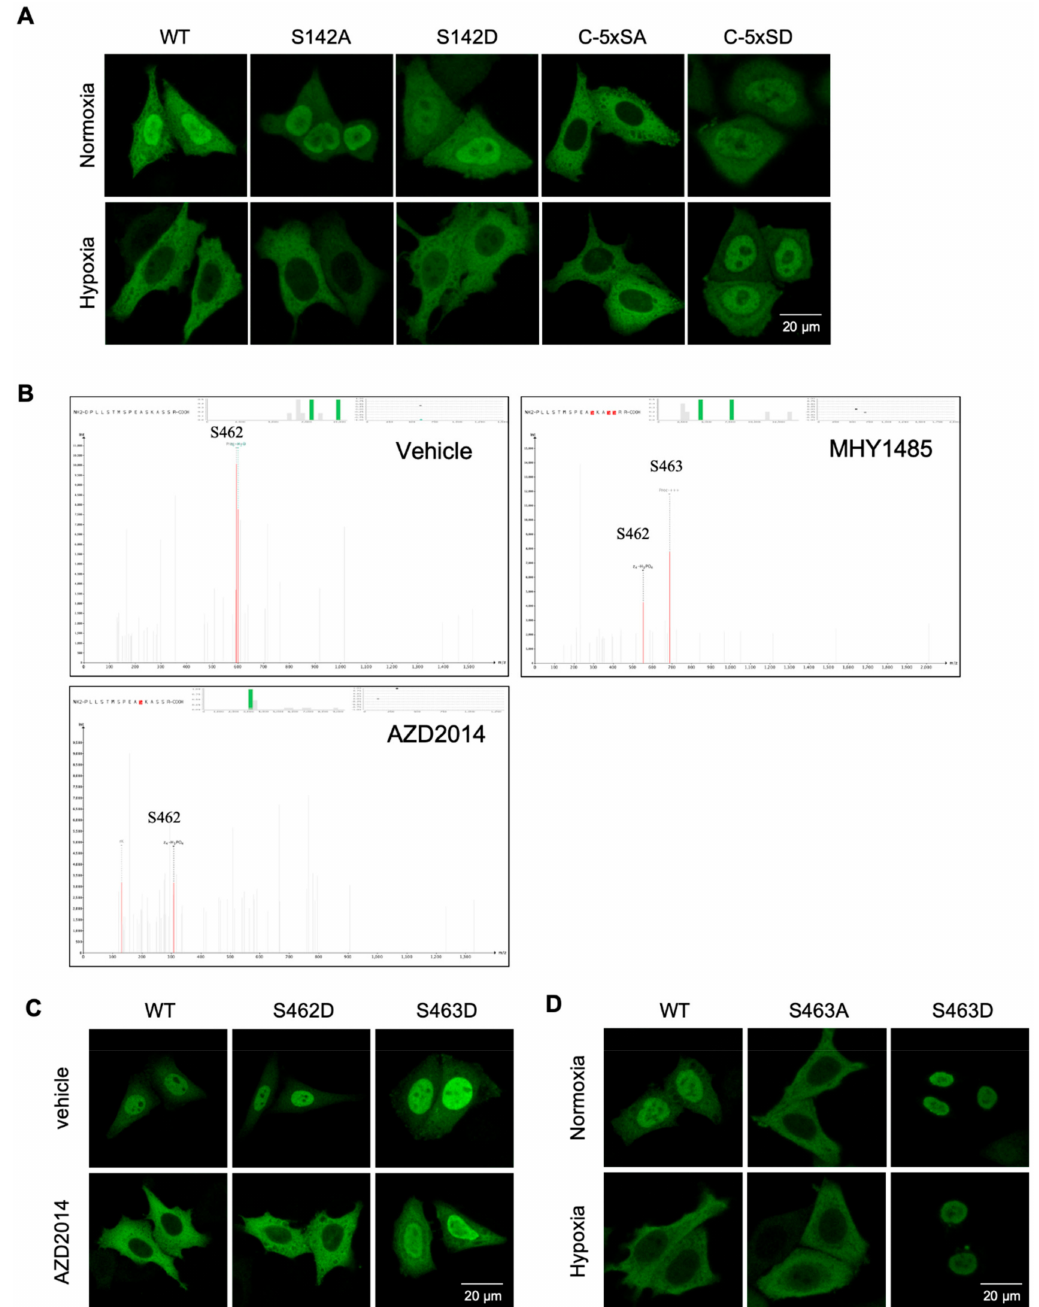
Figure 3. mTORc1 phosphorylates TFEB at S463. HeLa cells transfected with Myc tagged wild-type (WT) or TFEB mutant constructs were incubated in either 20% or 1% O 2 for 24 h, followed by immunostaining using Myc antibody ( A ). HeLa cells transfected with TFEB-Myc expression vectors for 1 day, followed by stimulation with vehicle control, 2 µ M of MHY1485, or 10 nM of AZD2014 for 30 min. TFEB was immunoprecipitated with antibodies against the Myc tag, followed by mass-spectrometry analysis ( B ). HeLa cells transfected with S462D or S463D mutants were stimulated with vehicle or 10 nM of AZD2014 for 30 min, followed by immunostaining for TFEB ( C ). HeLa cells transfected with S463A or S463D mutants were incubated in 20% or 1% O 2 for 4 h, followed by immunostaining for TFEB ( D ). Images were collected from confocal microscopy. Representative images are